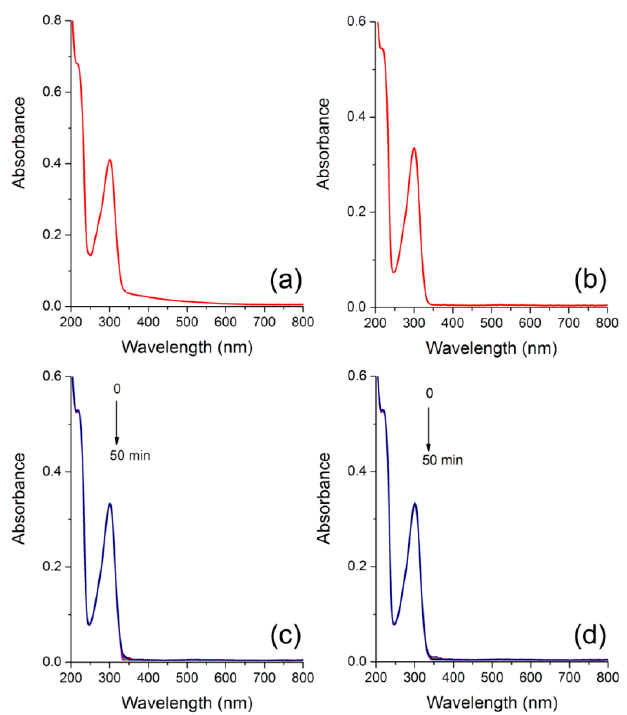
Figure 4. UV-Vis absorbance spectra of spiropyran 7 [10 − 5 mol · L − 1 ] in acetonitrile solution, at ( a ) 300 nm and ( b ) 365 nm irradiation for 5 min, and at ( c ) 300 nm and ( d ) 365 nm irradiation every 2 min for 50 min.